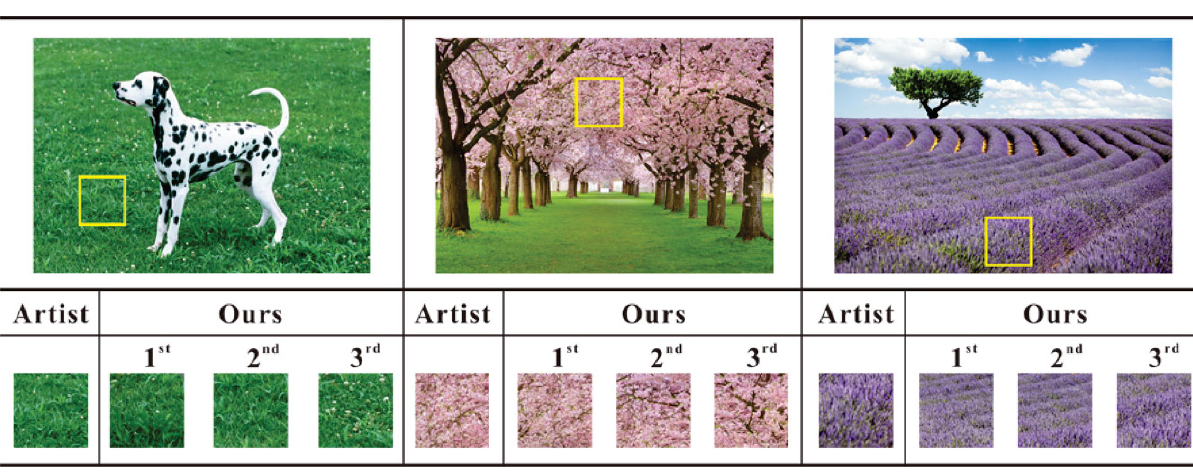
Fig. 9 Patches chosen by our method and those chosen by artists.